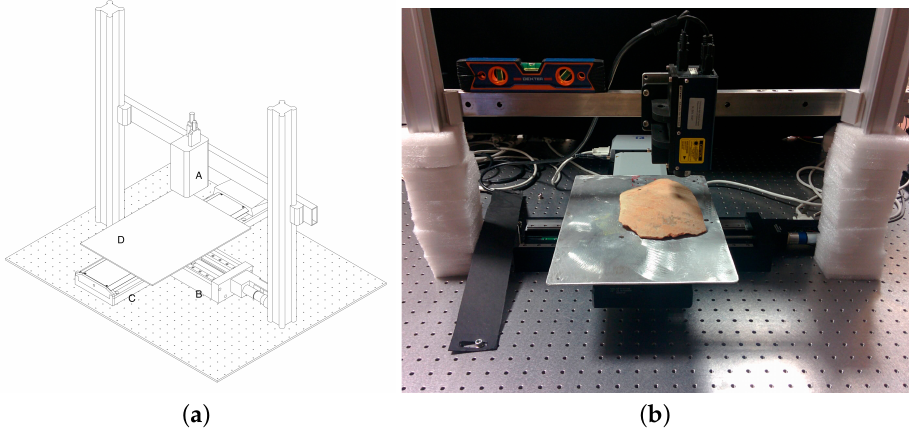
Figure 2. Microprofilometer horizontal setup. ( a ) sketch with the components specified. Conoscopic holography probe (A), linear stage (subscan axis) (B), linear stage (scan axis) (C), sample positioning plate (D). In this configuration, the probe is fixed while the object is moved by the axis stages in the horizontal plane. ( b ) application example in a real case